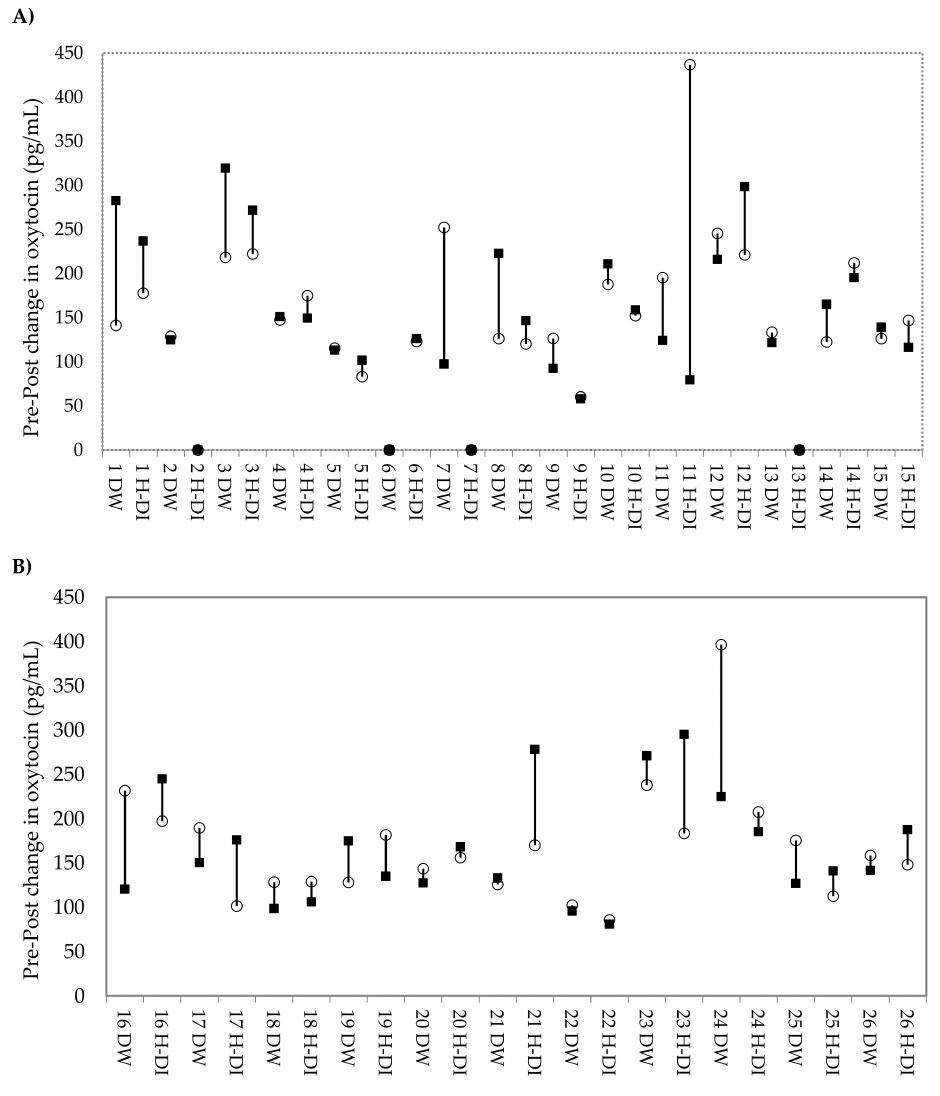
Figure 1. Change in urinary oxytocin concentration from pre to post condition for each dog. DW: dog-walking; H-DI: human–dog interaction. indicates the pre-condition concentration, and (cid:4) (cid:35) indicates the post-condition concentration. In the case and (cid:4) , both fall on 0, which indicates missing (cid:35) data ( n = 4 conditions). Dogs are displayed in order of ascending total MDORS score, from smallest to largest. ( A ) Dogs whose owners reported below median levels of attachment. ( B ) Dogs whose owners are reported above the median levels of